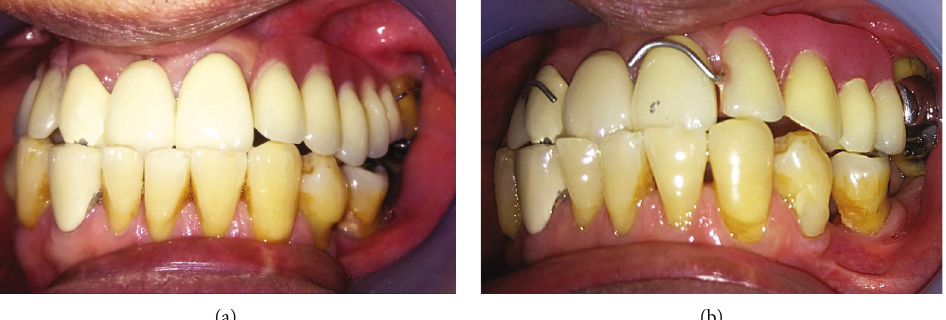
Figure 5: Comparison of maxillary denture design: (a) Faulty design of the previous denture with only a single clasp on tooth #26. (b) New design with multiple clasps for better distribution of